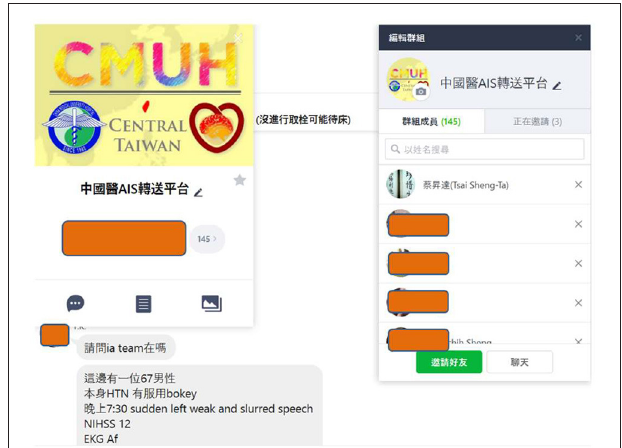
FIGURE 2 | A real communication on the “LINE” smartphone application. “A 67-year-old hypertensive male who took aspirin every day. He developed sudden-onset weakness of the left limbs and slurred speech, with NIHSS = 12. The EKG revealed atrial fibrillation. Ask for transfer”.